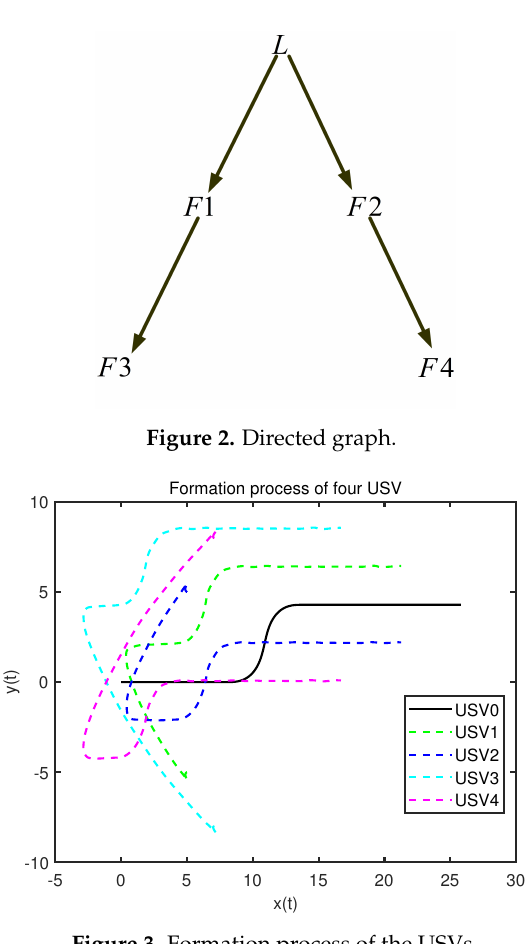
Figure 3. Formation process of the USVs.